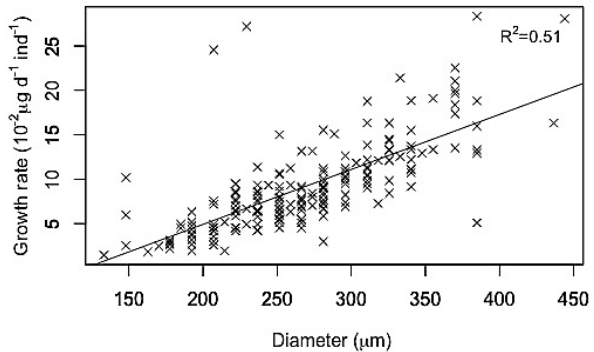
Fig. 3. Growth rates (10 − 2 µgd − 1 ind − 1 ) of all treatments versus diameter